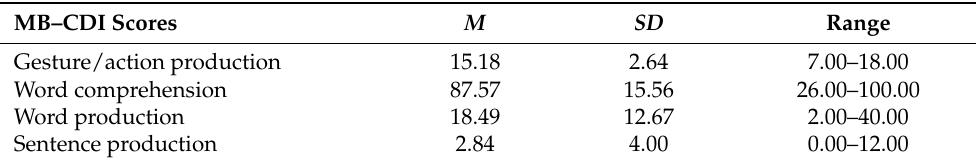
Table 3. Descriptive statistics of late talkers’ gesture/action production and word comprehension (MB–CDI Gestures and Words Short Form) and word and sentence production (MB–CDI Words and Sentences Short Form).